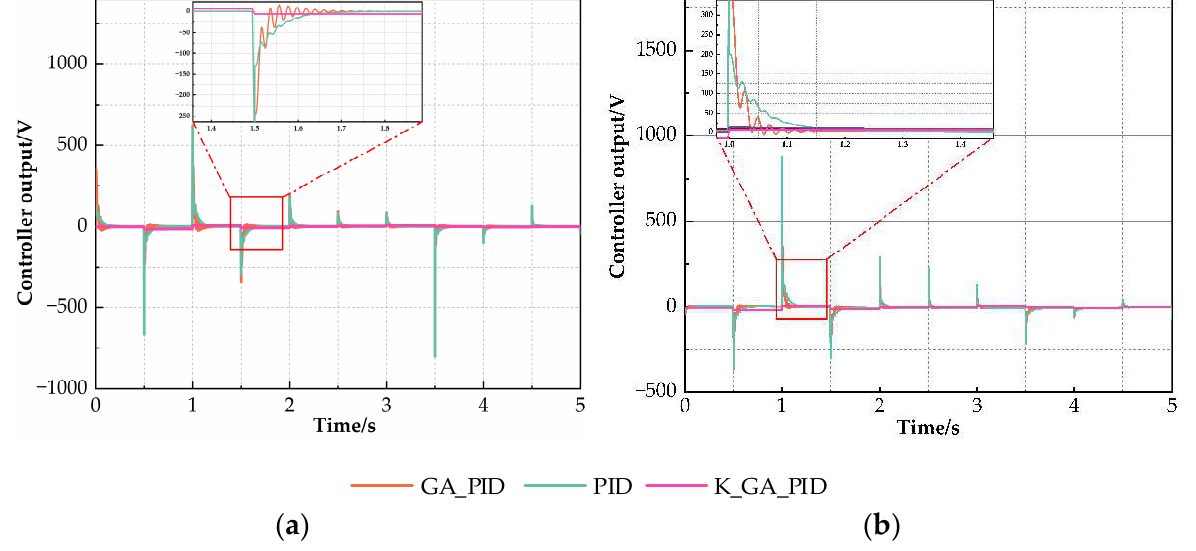
Figure 14. Output of PID and GA-optimized PID controllers under external disturbances. ( a ) Controller output under step signal input; ( b ) Controller output under sinusoidal signal input.